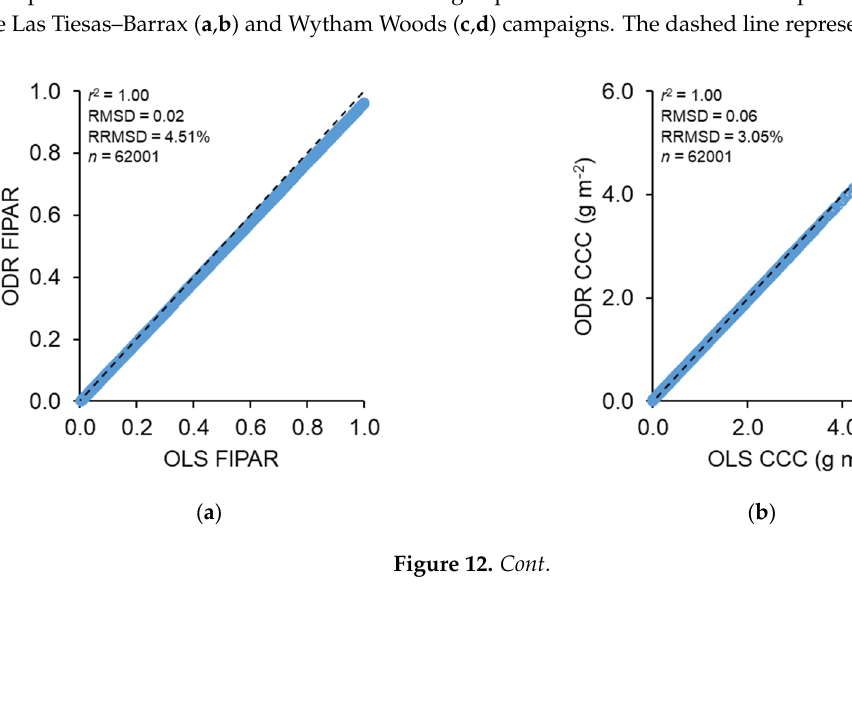
( d ) Figure 12. Comparison between ODR- and OLS-based high-spatial-resolution reference maps of FIPAR ( left ) and CCC ( right ) for the Las Tiesas–Barrax ( a , b ) and Wytham Woods ( c , d ) campaigns. The dashed line represents a 1:1 relationship.